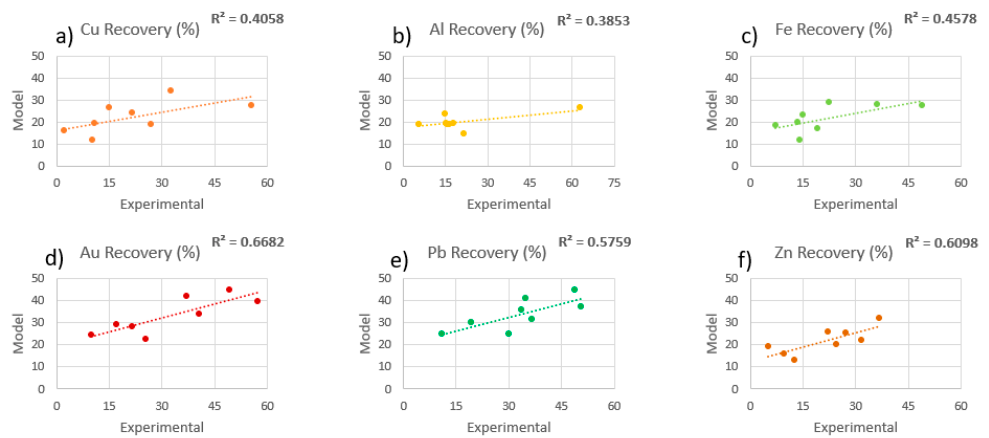
Figure 14. Correlation between the experimentally determined and calculated metal recovery using the model equations after hammer milling for product size fraction 1–2 mm. ( a ) Cu, ( b ) Al ( c ) Fe, ( d ) Au, ( e ) Pb, and ( f ) Zn. Feed particle size fraction was 2–4 mm.